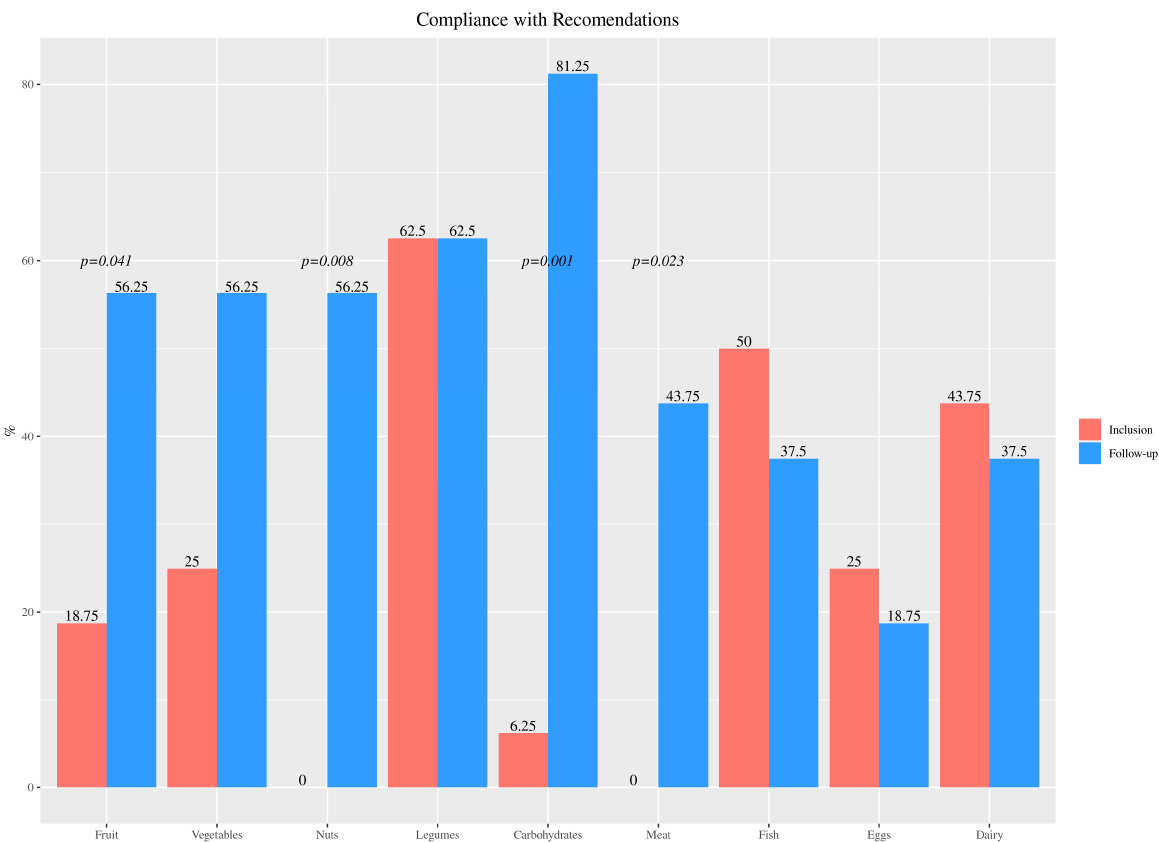
Figure 2. Percentage of participants with chronic kidney disease meeting the Spanish nutritional recommendations for fruit, vegetables, nuts, legumes, complex carbs (grains and tubers), meat, fish, eggs, and dairy, at baseline and last follow-up after nutrition intervention.